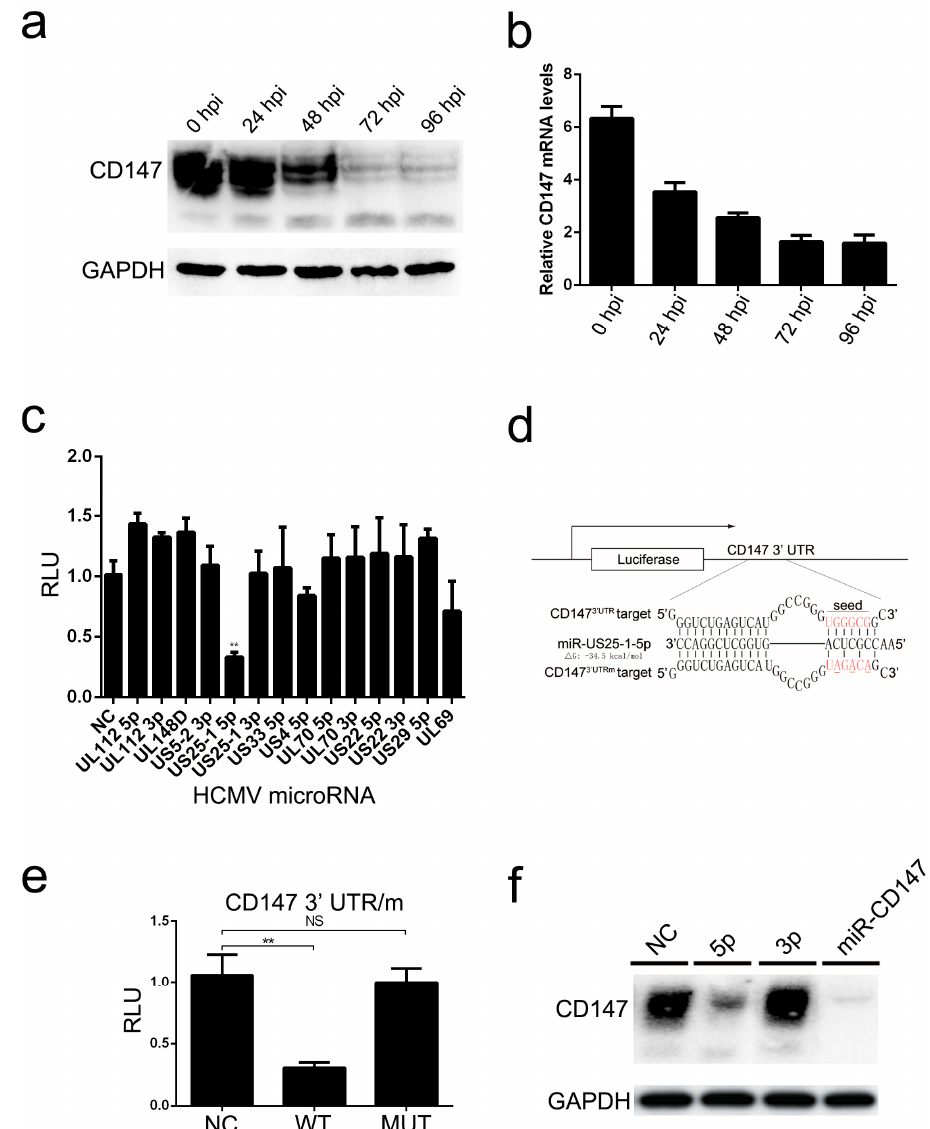
Figure 3. CD147 is targeted and down-regulated by HCMV miR-US25-1-5p. ( a ) Western blot analysis of CD147 protein levels in total protein lysates of HFF cells at the indicated times post HCMV infection (MOI = 5); ( b ) Quantitative RT-PCR analysis of CD147 mRNA expression levels in HFF cells at the corresponding time points post-HCMV infection (MOI = 5); ( c ) Dual luciferase reporter assay in 293 cells suggests that CD147 3 ′ UTR is targeted by miR-US25-1-5p. A luciferase reporter plasmid pmirGLO-CD147 3 ′ UTR was tested; the 14 putative HCMV mimics are outlined in the abbreviations. Stars indicate potential down-regulated relative luciferase activities and the corresponding p value; ( d ) Schematic of miR-US25-1-5p-binding sites on CD147 3 ′ UTR (CD147 3 ′ UTR ) and its mutant CD147 3 ′ UTRm , with the seed-recognizing site marked in red. The predicted hybrid free-energy of miR-US25-1-5p is indicated; ( e ) Confirmation of the predicted target site for miR-US25-1-5p. The 293T cells were co-transfected with miR-US25-1-5p mimic and the luciferase reporter pmirGLO-CD147 3 ′ UTR (WT) or pmirGLO-CD147 3 ′ UTRm (MUT) for 36 h before dual luciferase reporter assay; and, ( f ) Confirmation that miR-US25-1-5p (5p), but not miR-US25-1-3p (3p) specifically down-regulates endogenous CD147 in U251 cells transfected as indicated and harvested two days after transfection for Western Blot analysis. Commercial non-targeting control siRNAs (NC) and CD147-specific siRNAs (siCD147) were used for comparisons. The graphical data are presented as the means ± the SDs ( n = 3); NS denotes not significant ( p > 0.05); ** denotes p < 0.01.